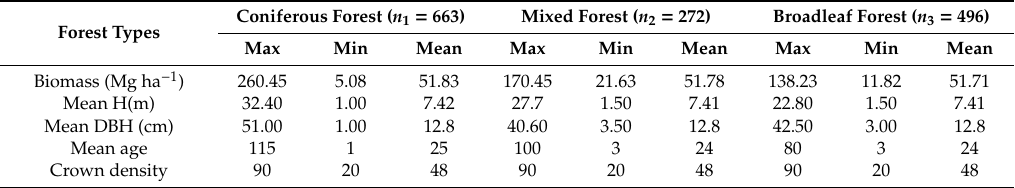
Table 1. Statistics of the main forest inventory dataset (plot number and biomass of the three forest types in Beijing,